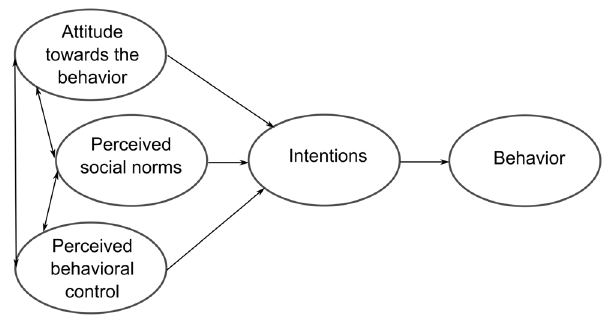
Figure 3. Ajzen’s model of planned behavior. Source: Ajzen [24].